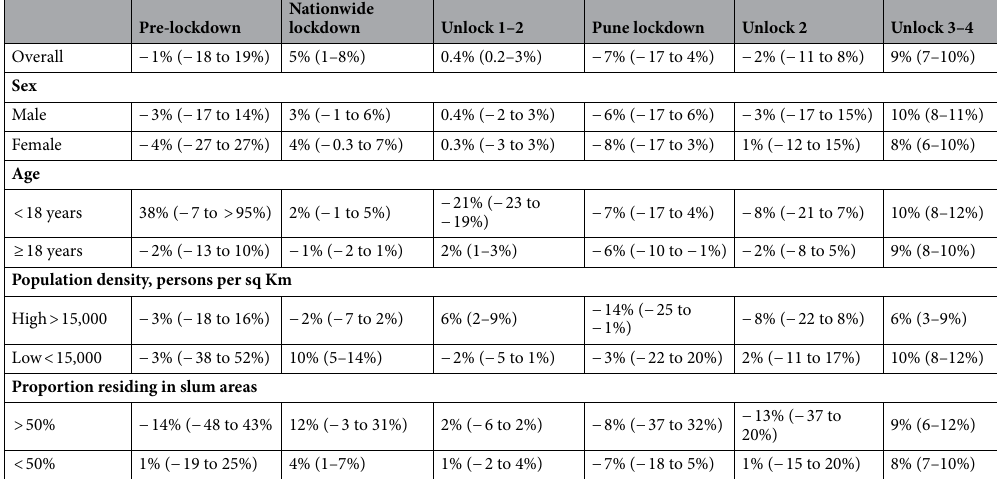
Table 2. . Percent change (95% CI) in weekly incident COVID-19 infections by lockdown phase in the overall dataset and by population characteristics a . a Pre-Lockdown (Feb 1–March 24, 2020); Nationwide Lockdown